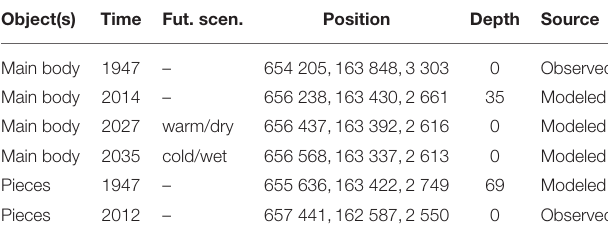
TABLE 1 | Position and depth of the main body of the Dakota and emerged pieces (Swiss coordinate system, CH1903) at different times and under both future climate